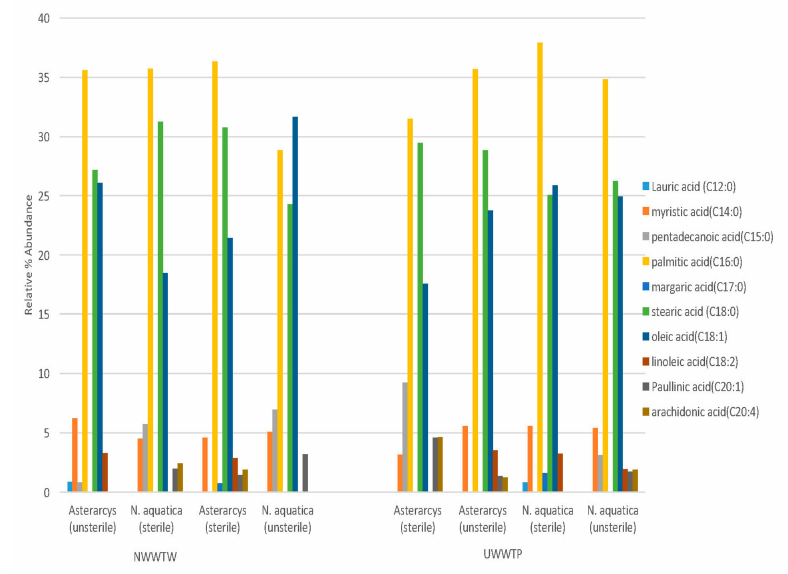
Figure 2. Fatty acid methyl-esters (FAMEs) composition of indigenous microalgae grown in sterilized and raw wastewater